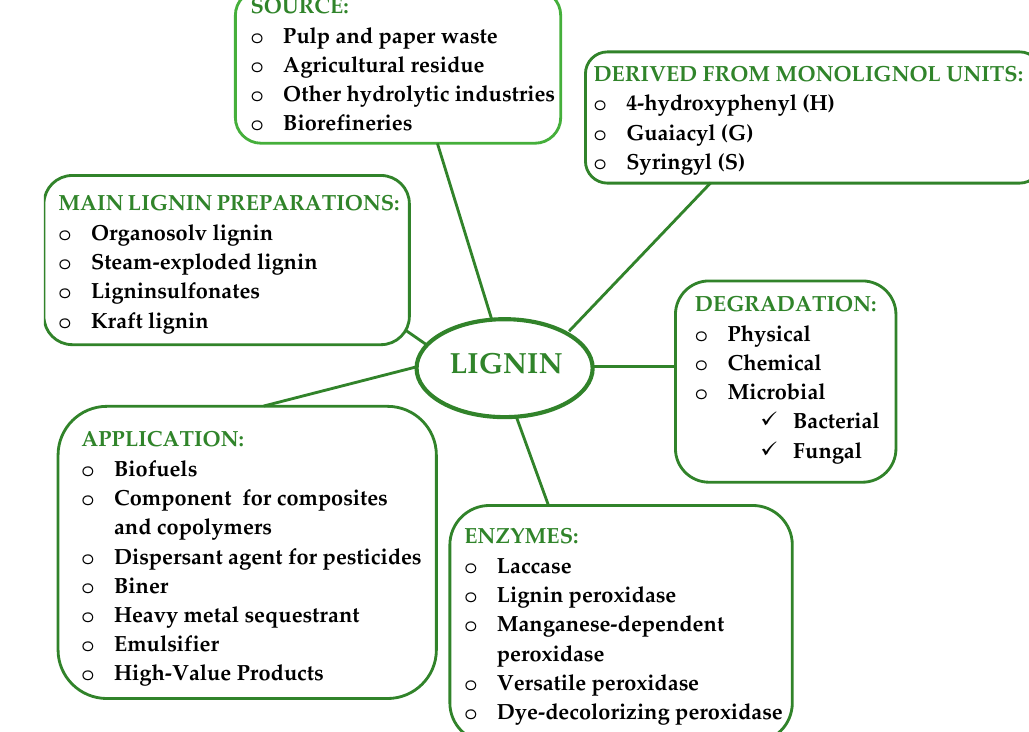
Figure 2. The source of lignin, monolignol units, main lignin preparations, application of lignin, degradation of lignin, and enzymes involved in lignin degradation.